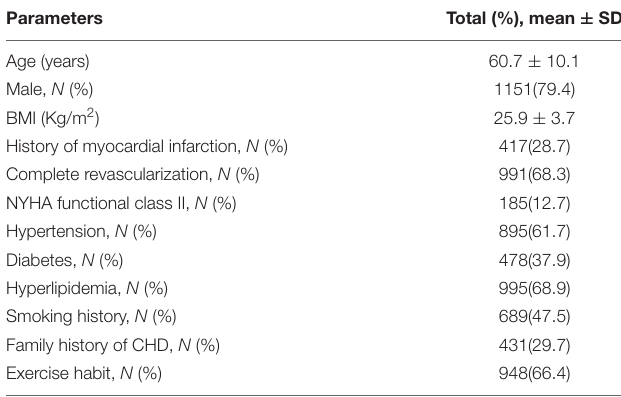
TABLE 1 | Clinical information of patients with CHD after PCI in the development